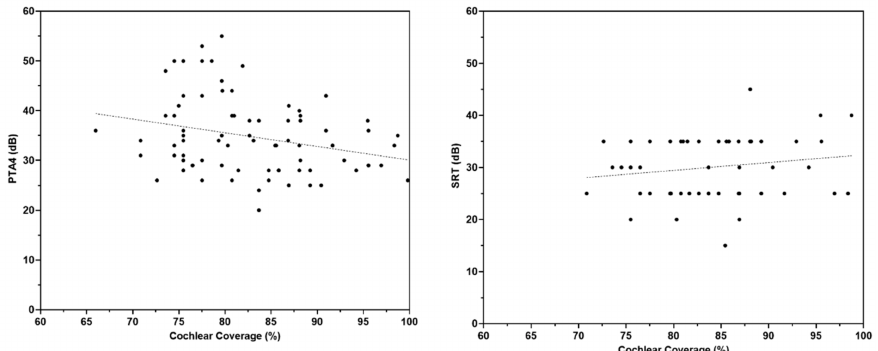
Figure 1. Regression analysis comparing the cochlear coverage with mean pure tone threshold (PTA4; left panel ) and speech reception threshold (SRT; right panel ).